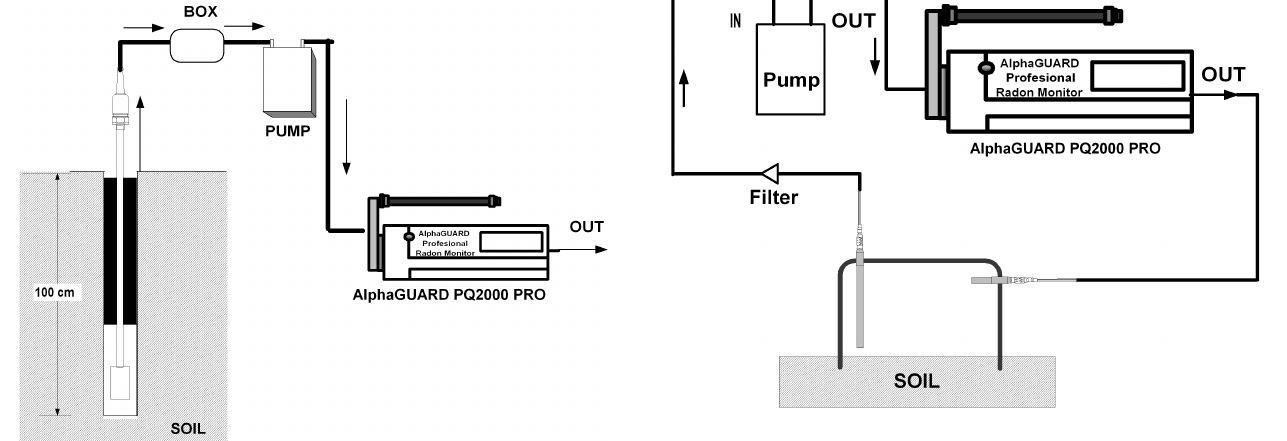
Fig. 4. Radon exhalation measurement.